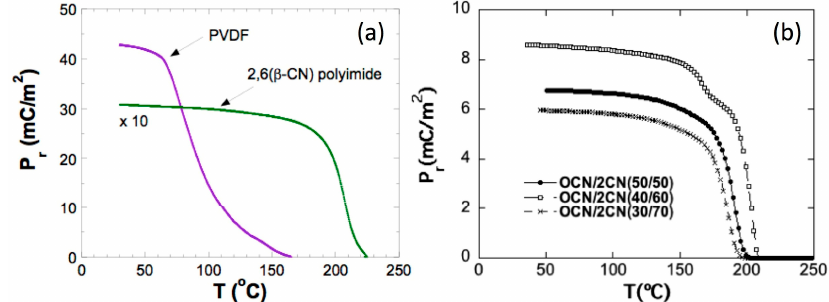
Figure 11. ( a ) Measured remnant polarization as a function of temperature for commercial PVDF piezoelectric polymer and the 2,6( β -CN)APB/ODPA (poly 2,6) polyimide; ( b ) The remnant polarization of three copolyimides as a function of temperature. Reprinted from [53] with permission of the authors. Copyright 2013 IEEE.